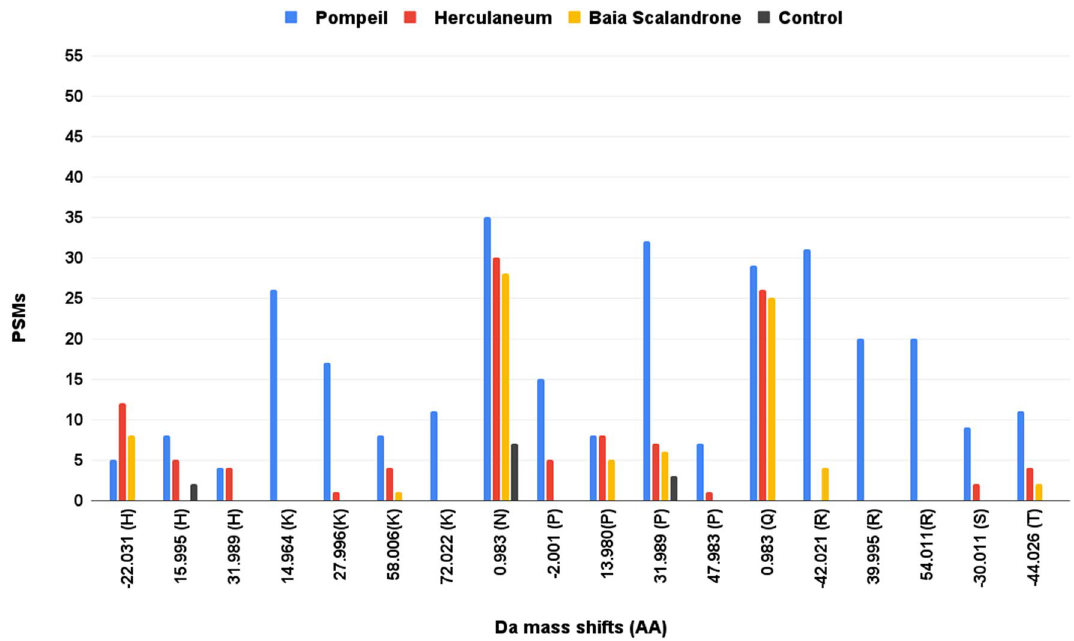
Figure 3. Peptide-spectrum matches (PSMs) of “dependent peptides” with mass shifts in the type I collagen chains in the sample groups of Pompeii, Herculaneum, Baia Scalandrone and control samples (H-142, H-162 34 ). Mass shifts were selected after filtering with localization probabilities of ≥ 80% for modified peptides and occurrence of detection of DP Cluster Mass ≥ 5 times for each sample. Reported data only include mass shifts corresponding to known oxidative modifications with matching amino acid targets (Unimod, http:// www. unimod. org/).